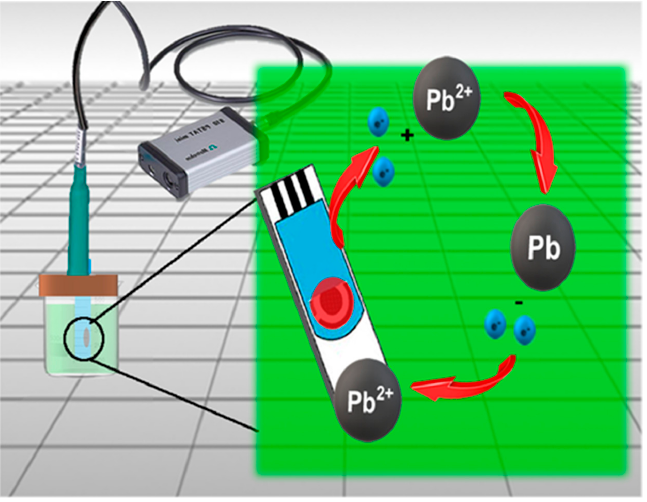
Figure 6. Representation of CNF ‐ FeOx electrode in Pb redox process.